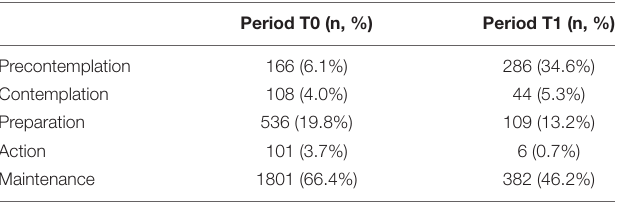
TABLE 1 | Distribution of SoC for PA between the periods T0 and T1.